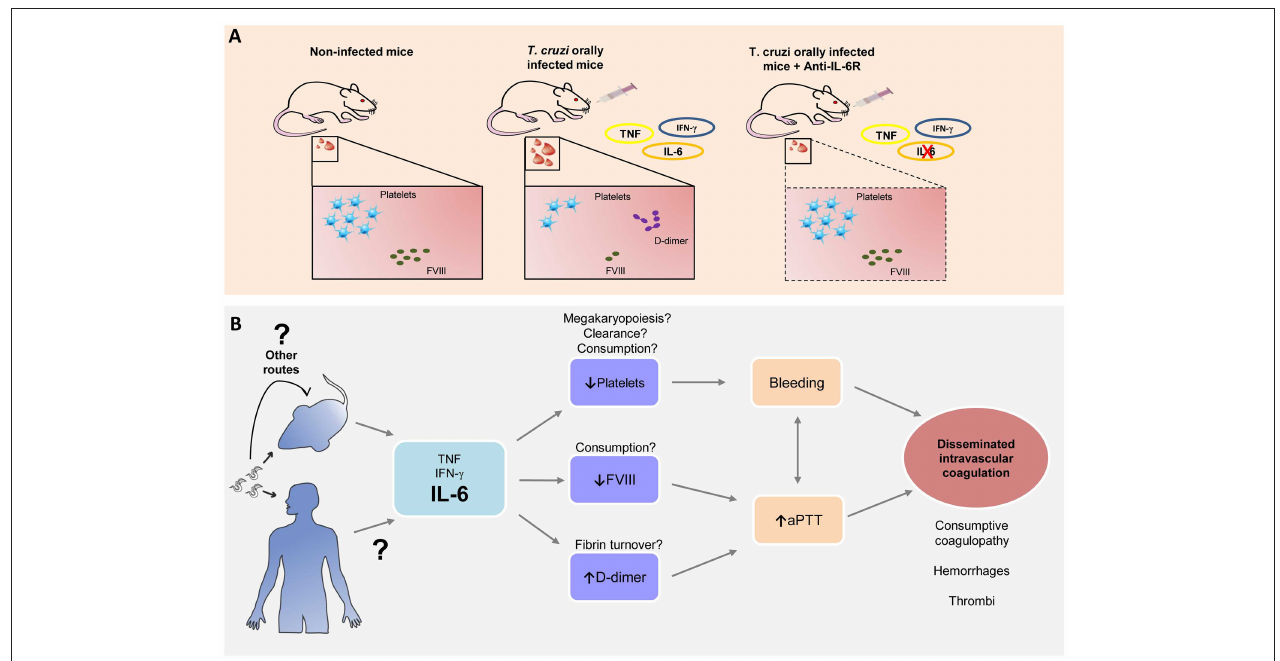
FIGURE 6 | Trypanosoma cruzi oral infection causes hemostatic derangement linked to a systemic inflammation. (A) Trypanosoma cruzi orally infected mice have thrombocytopenia, Factor VIII depletion and increased D-dimer levels, linked to a systemic inflammation. Blocking of IL-6 signaling restores normal hemostasis. (B) Hypothesis: Acute T. cruzi infection leads to increase of pro-inflammatory cytokines. IL-6 is associated with a decrease with platelet count, possibly due to megakaryopoiesis disturbances, platelet clearance and/or consumption; reduction in serum FVIII levels and high levels of D-dimer related to fibrin turnover. Altogether these processes are involved in the increase of bleeding tendency and aPTT, signs of disseminated intravascular coagulation that leads to microhemorrhages and microthrombi as previously reported ( 7, 13,